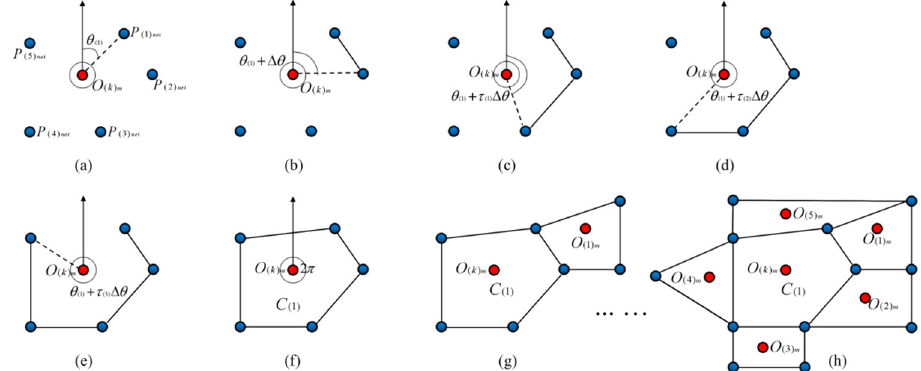
Figure 2. The process of forming the space C based on O ( k ) and P ( v ) . ( a – f ) illustrate the process of forming the cellular unit C ( 1 ) , and ( g , h ) illustrate the topological process of forming the cellular space C based on the cellular unit C ( 1 ) .